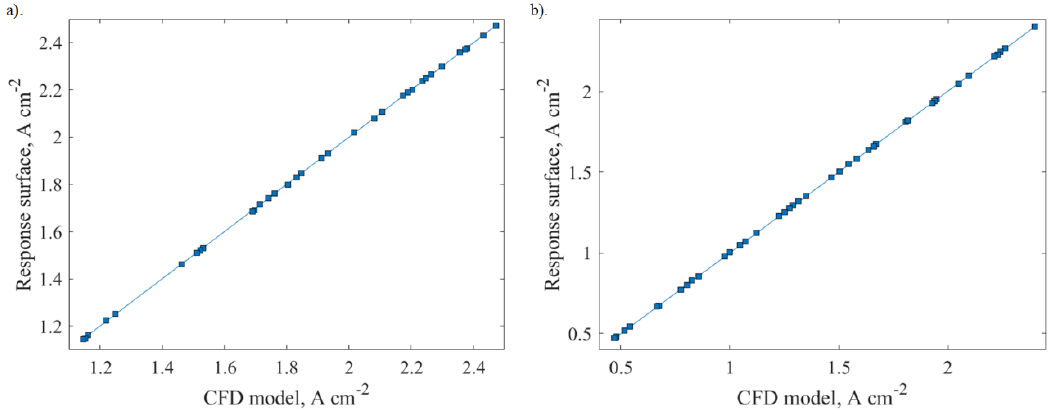
Figure 6. Goodness of fit for response surface generated at: ( a ) 0.8 V and ( b ) 0.6 V.